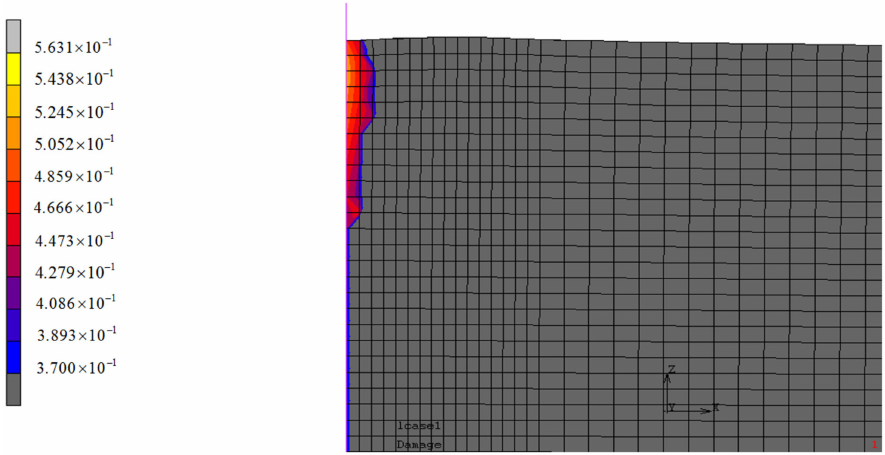
Figure 20. Cockroft–Latham indication of material failure in the